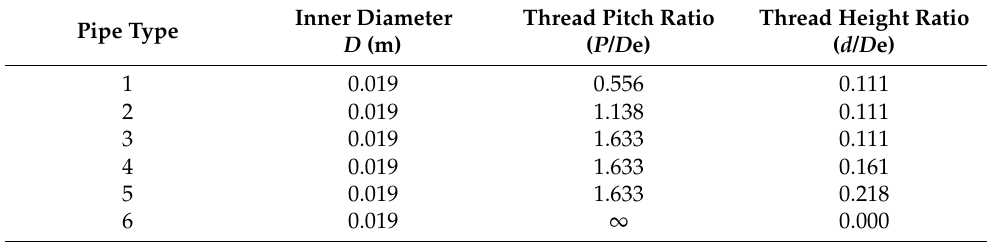
Figure 1. Schematic diagram of a SCP: ( a ) global view, ( b ) F-F cross-section plane. Table 1. Parameters of spiral corrugated pipe models.